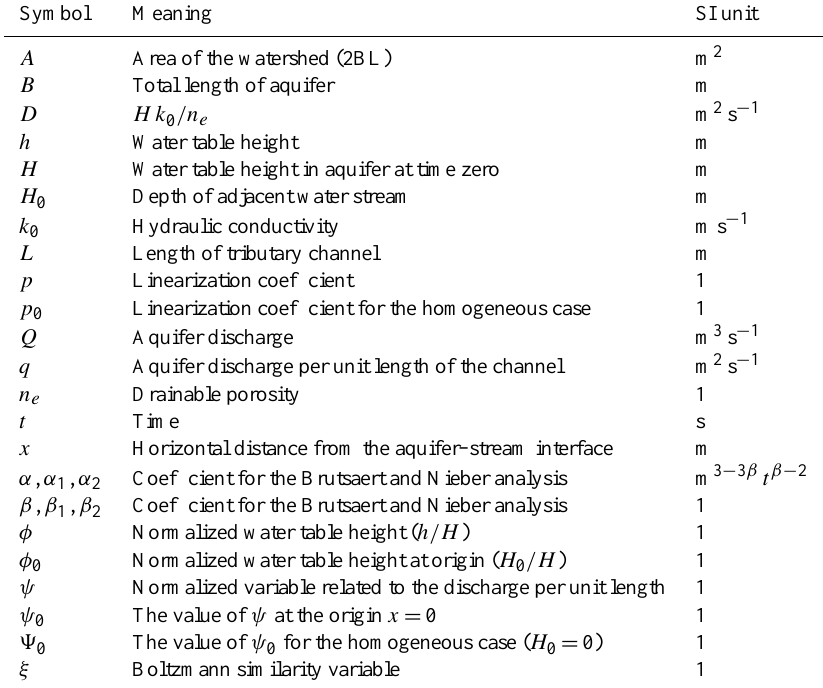
Table A1. List of symbols used throughout the